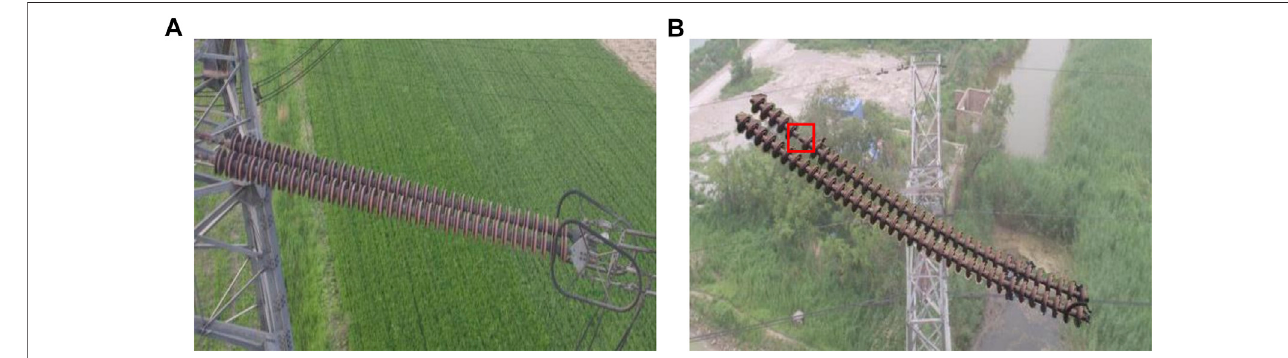
FIGURE 1 | Images of a normal insulator (A) and a defective insulator (B) , where the defect is marked with a red rectangular